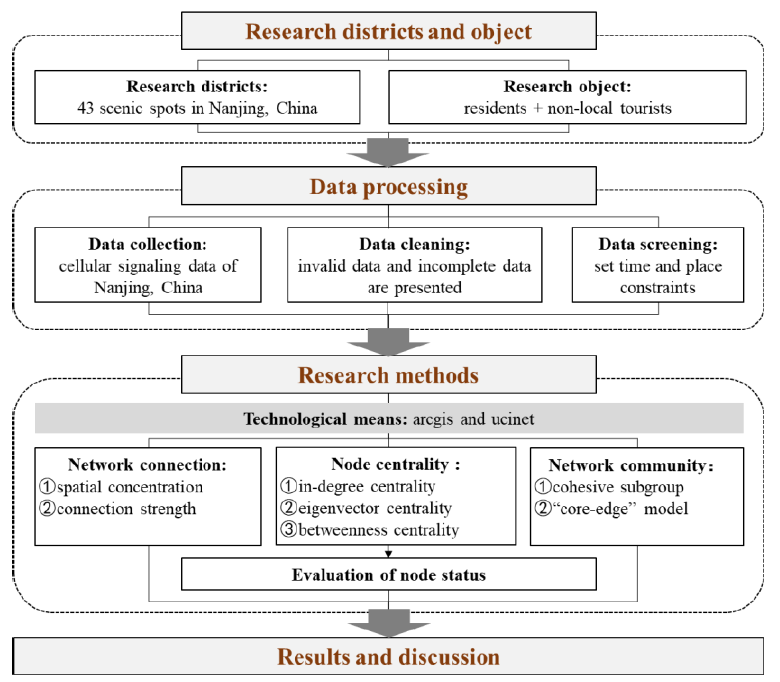
Figure 2. Research methodology.